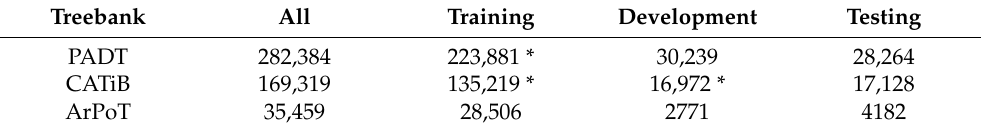
Table 3. Fine-tuned datasets statistics. Table 4. POS tags and Dependency Relations Labels in each dataset. Treebank